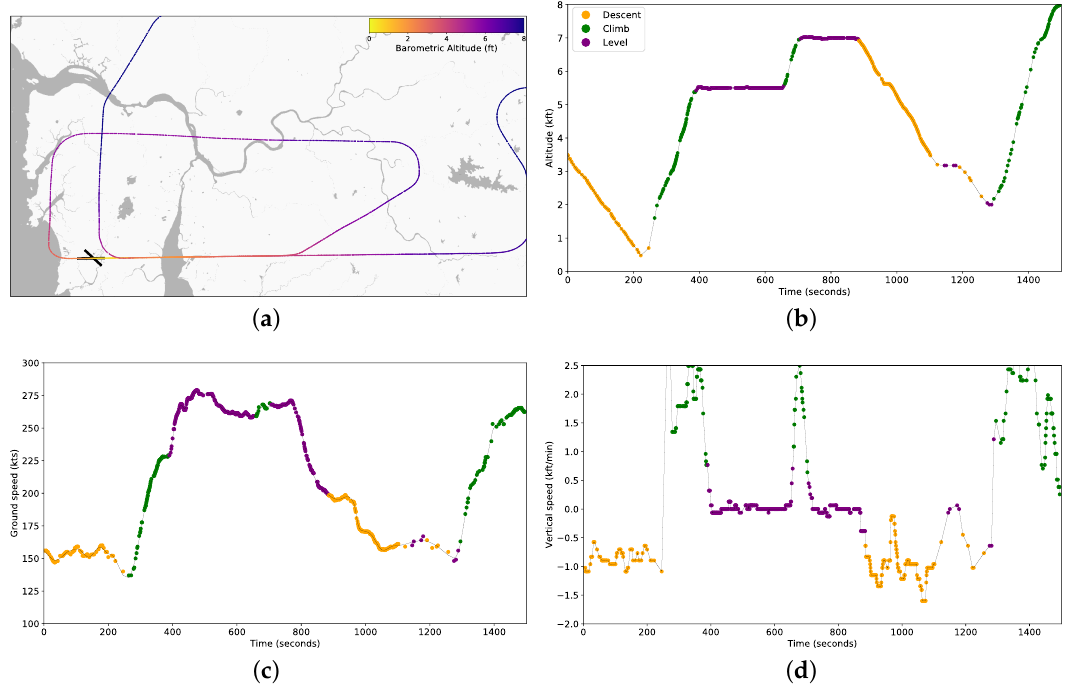
Figure 1. An example showing the flight profile for Indigo flight 5384 that performed two go-arounds at VABB on 1 July 2019 before diverting to land at another airport. ( a ) Overhead map showing horizontal position of aircraft. ( b ) Altitude profile of the go-around attempts, colour-coded by flight phase. ( c ) Ground speed profile ( d ) Vertical speed